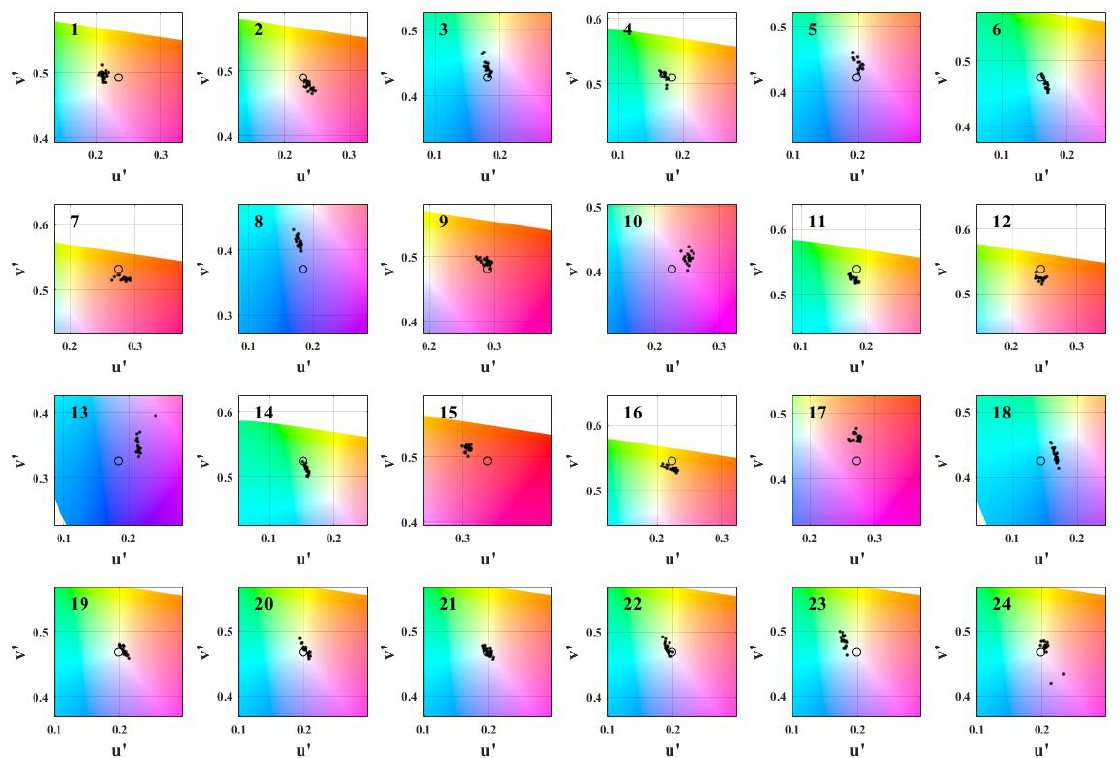
Figure 10. Color restoration results in CIE using lognormal area with 5 as the number of accumulated pulses. Each sub-figure corresponds to a color square, its center is the true coordinate (u, v) of the color square and its size is 0.2 × 0.2.